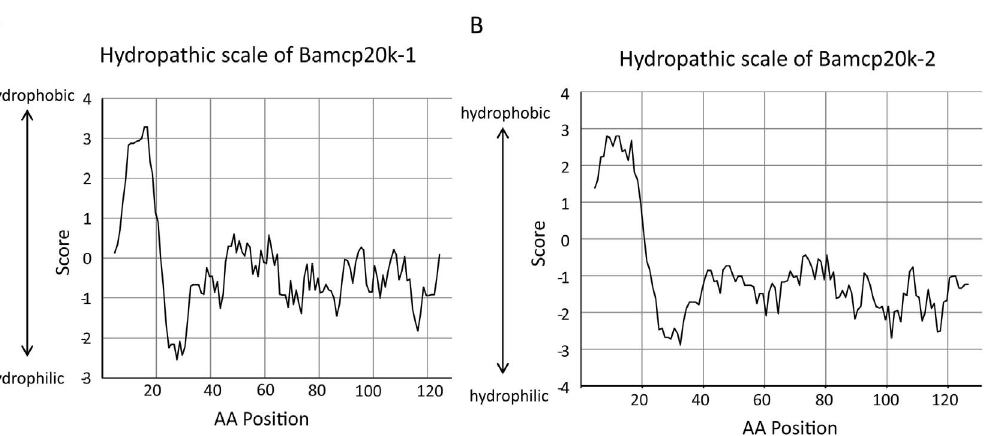
Figure 7. Hydrophobicity analysis of Bamcp20k-1 and cp20k-2. (A) and (B) amino acids derived from the sequences of Bamcp20k-1 and cp20k-2 were analyzed for hydrophobicity property. The x-axis indicates the amino acid position; y-axis indicates the score of hydrophilicity and hydrophobicity.